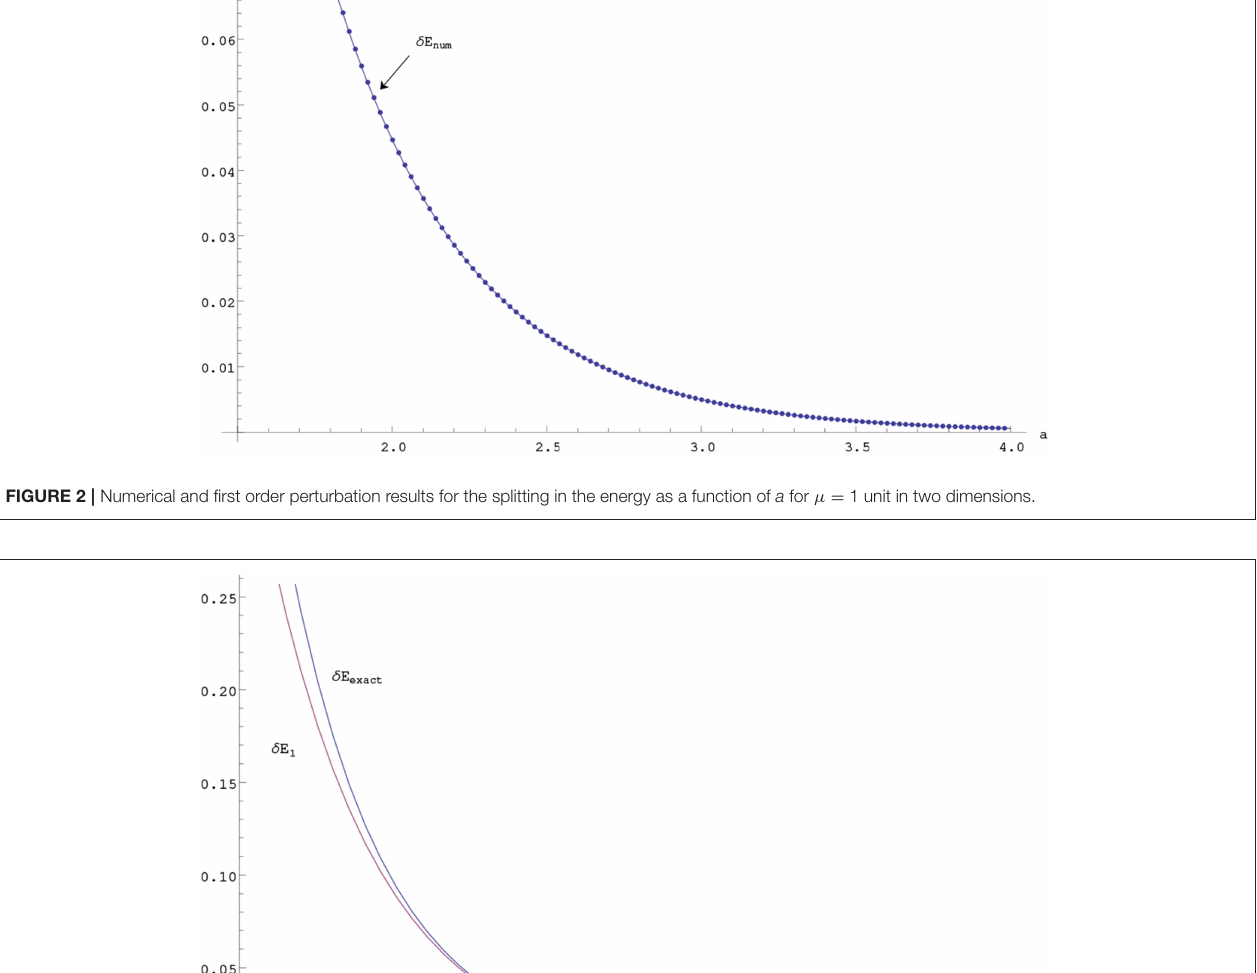
FIGURE 3 | Exact and first order perturbation results for the splitting in the energy as a function of a for λ